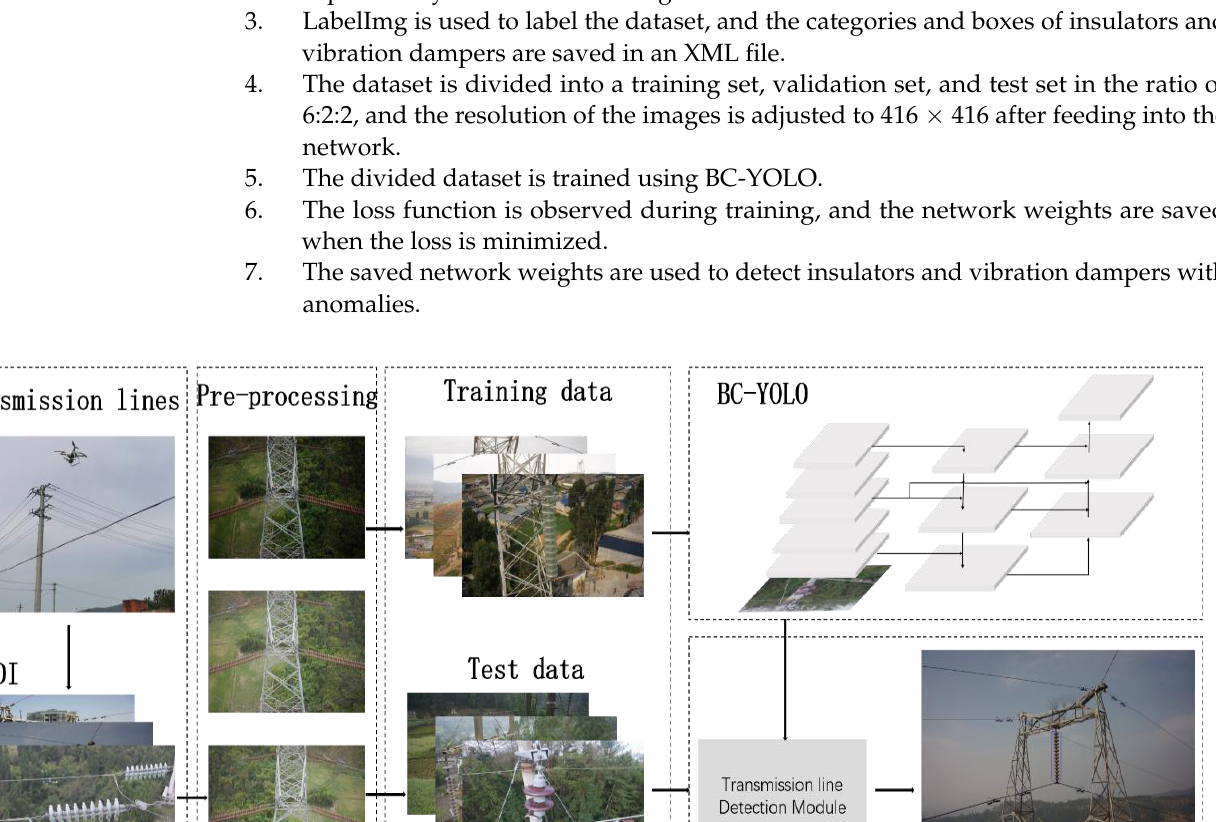
Table 2. Software and hardware configuration of the experimental environment.